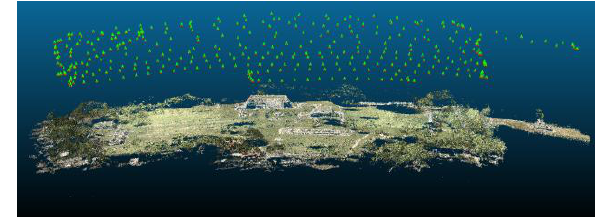
Figure 7. Cempoala archaeological site (Google)